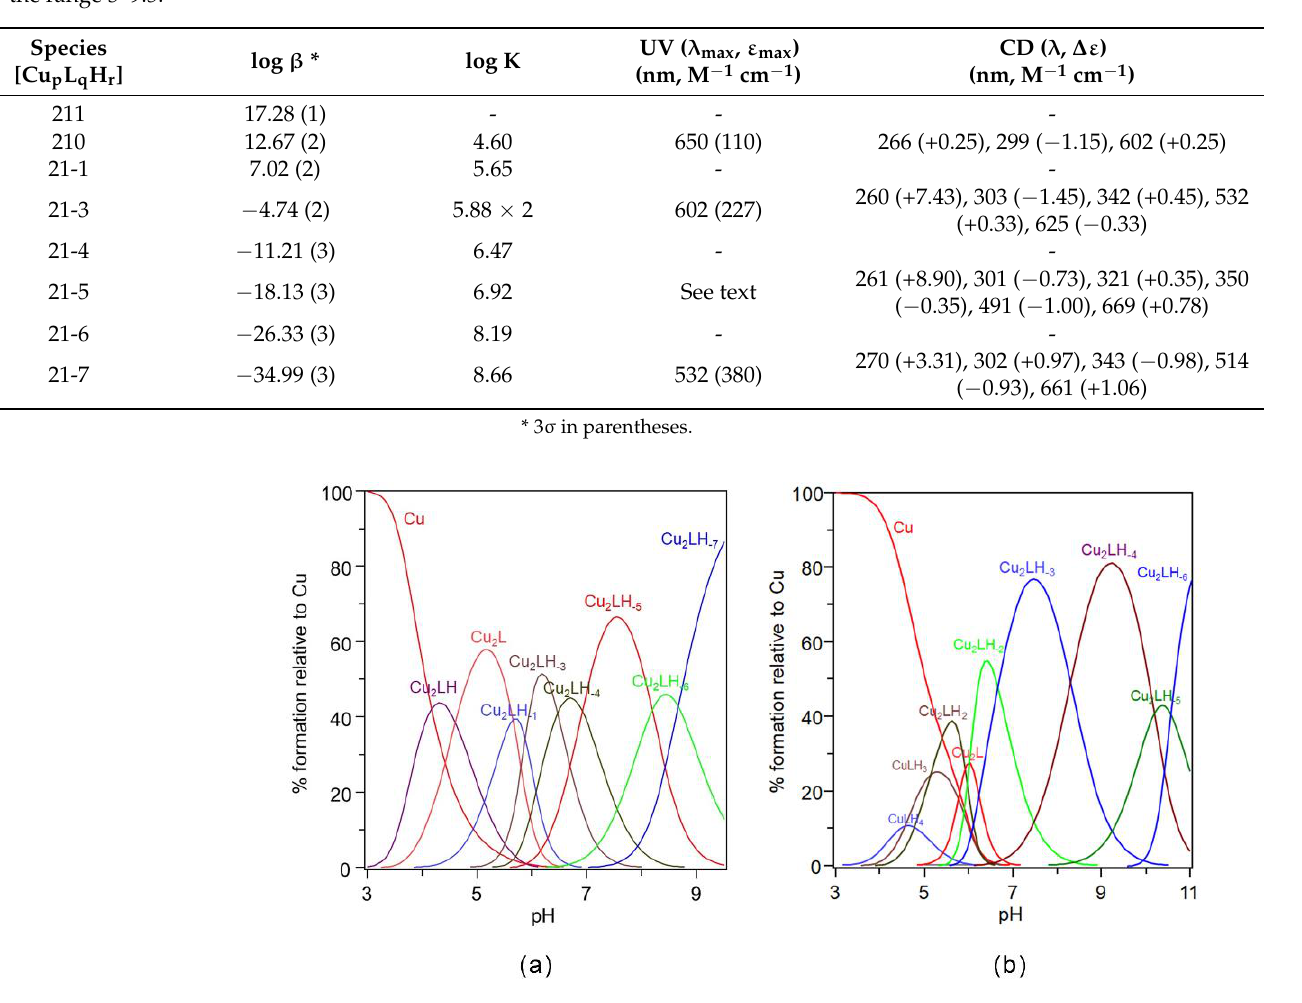
Table 1. Log β and log K values obtained from the titration of the Cu–Ang1-17 system (2:1), by varying the solution pH in the range 3–9.5.